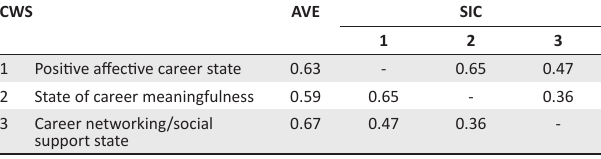
TABLE 2: Average variance extracted and squared inter-construct